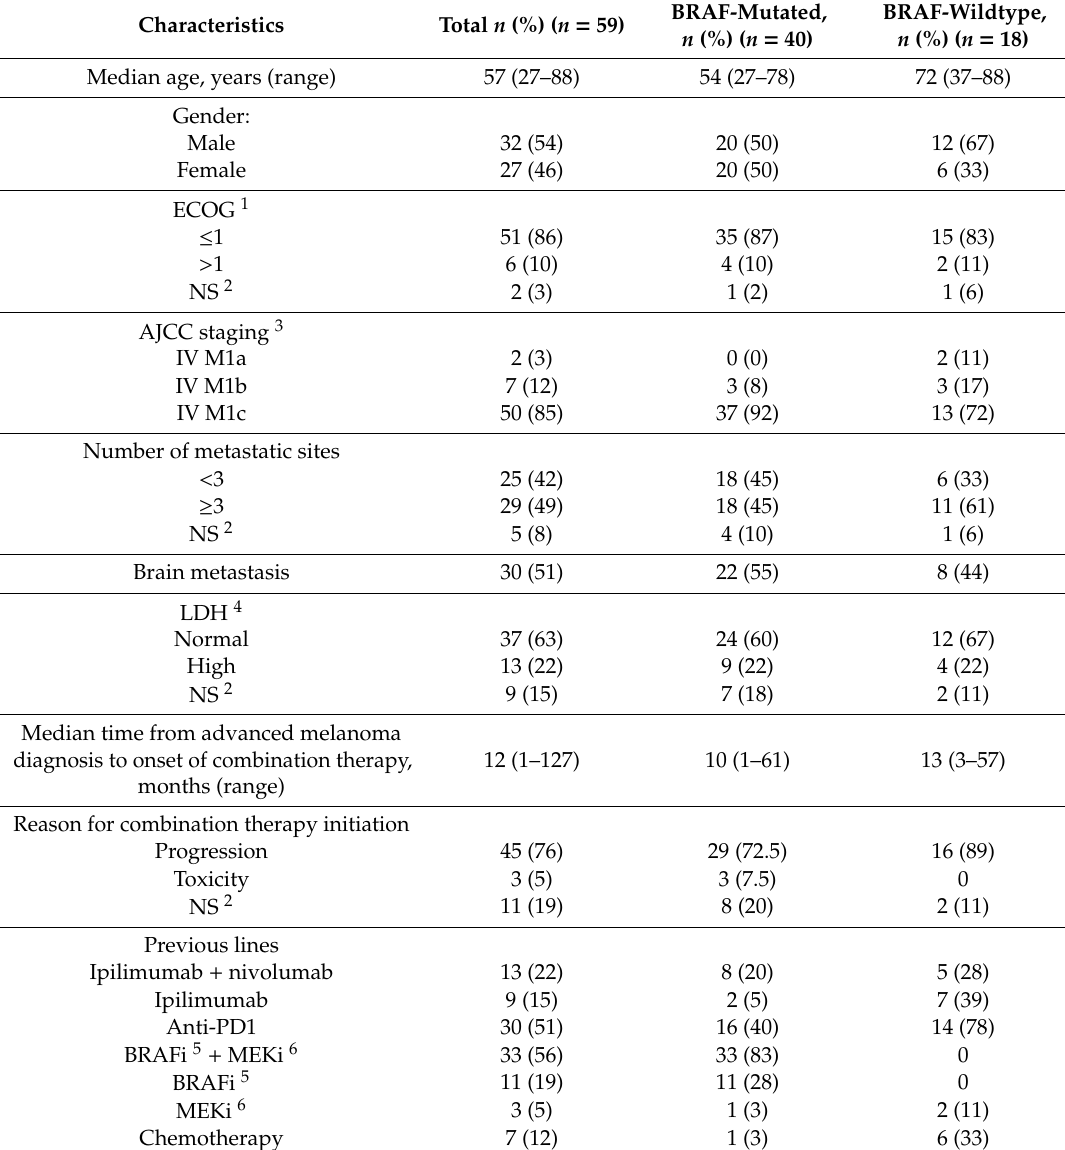
Table 1. Patients’ baseline characteristics at combined anti-PD1 + BRAF inhibitor and / or MEK inhibitor